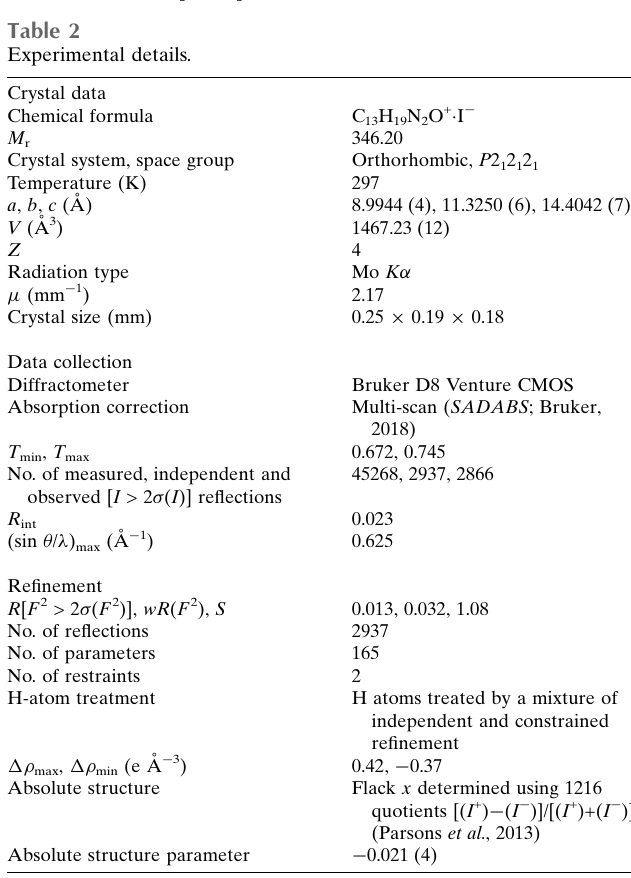
Table 2 Experimental details.